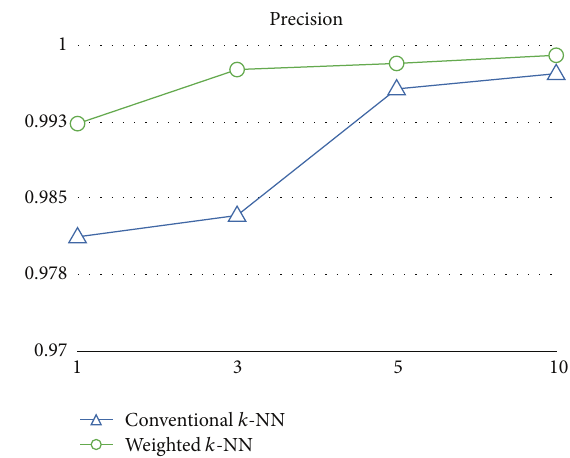
Figure 8: Precision of the conventional 𝑘 -NN classifier and the weighted 𝑘 -NN classifier on different 𝑘